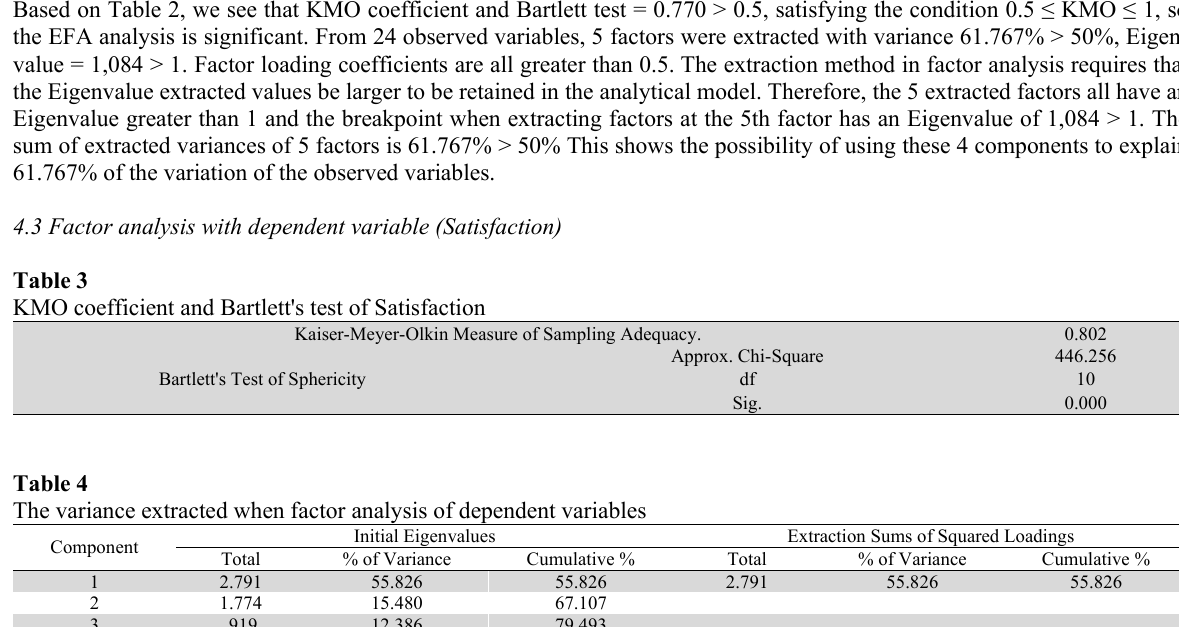
KMO coefficients and Bartlett's test of independent variables KMO coefficient ( Kaiser-Meyer-Olkin ) 0.770 Approx. Chi-Square 3268.407 Bartlett's test of the scale df 276 Sig. 0.000